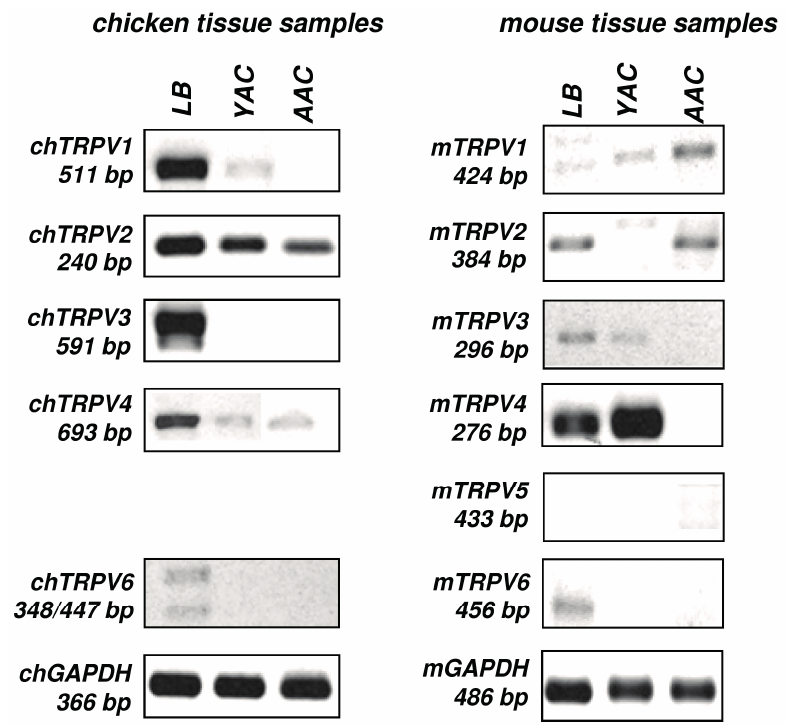
Figure 1. Conventional PCR analysis of TRPV expression in chicken (ch) and mouse (m) tissue samples. TRPV mRNA expression was monitored in chicken and mouse limb buds (LB), articular cartilage derived from young (YAC), and adult animals (AAC). Glyceraldehyde 3-phosphate dehydrogenase (GAPDH) was used as an internal control. Chicken TRPV5 expression was not analysed due to unknown sequence data. Representative data of three independent